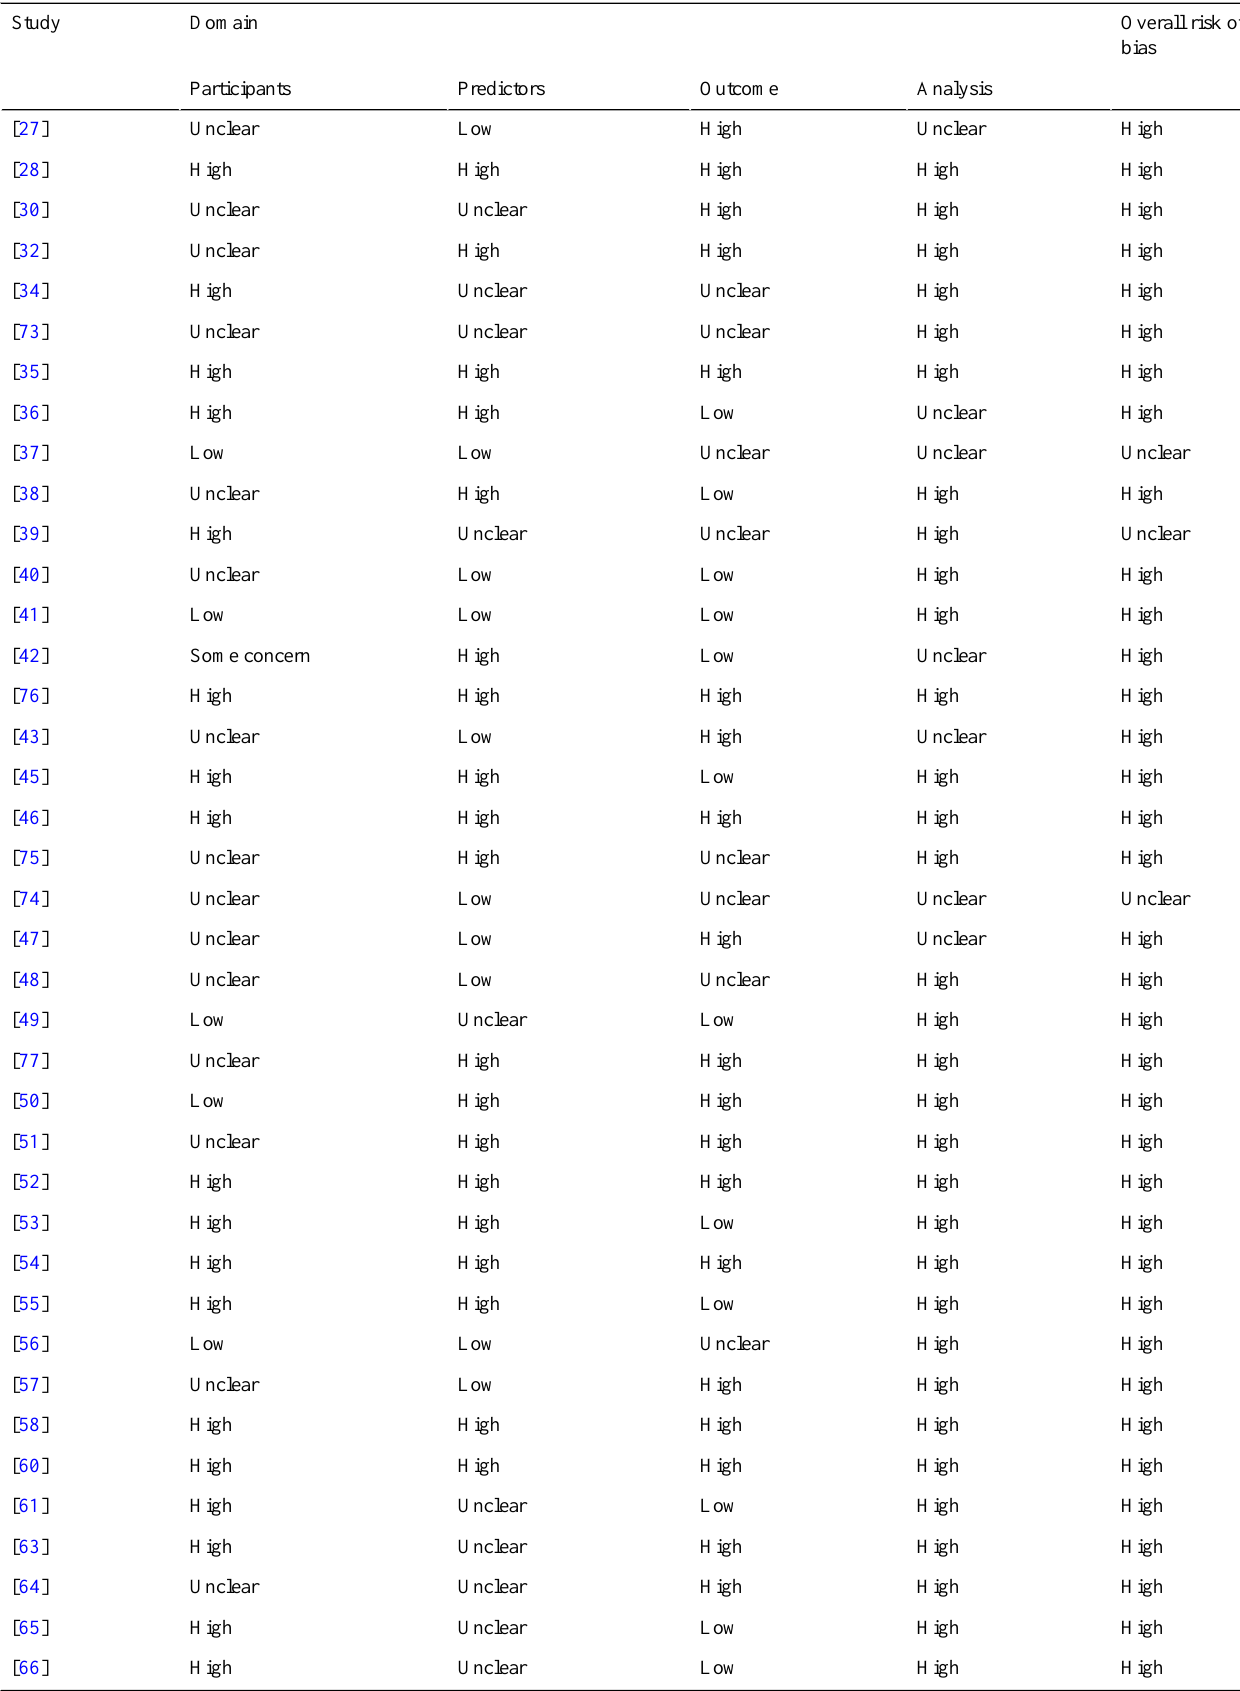
Table 2. Risk of bias assessment (using Prediction Model Risk of Bias Assessment Tool) based on four domains conducted for all studies included in the